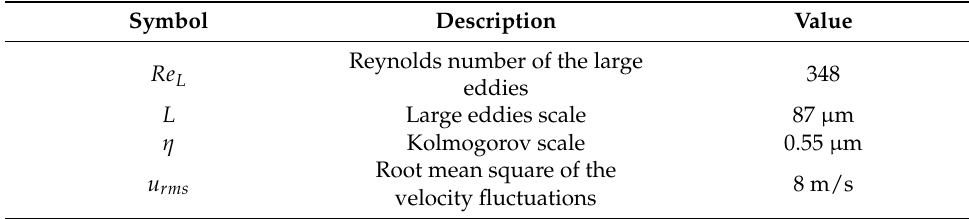
Figure 1. Direct numerical simulation strategy schematic: coupling between the precursor and the main simulation ( a ), boundary conditions, and the geometry of the main simulation ( b ). Table 1. Radially averaged turbulence characteristics at the